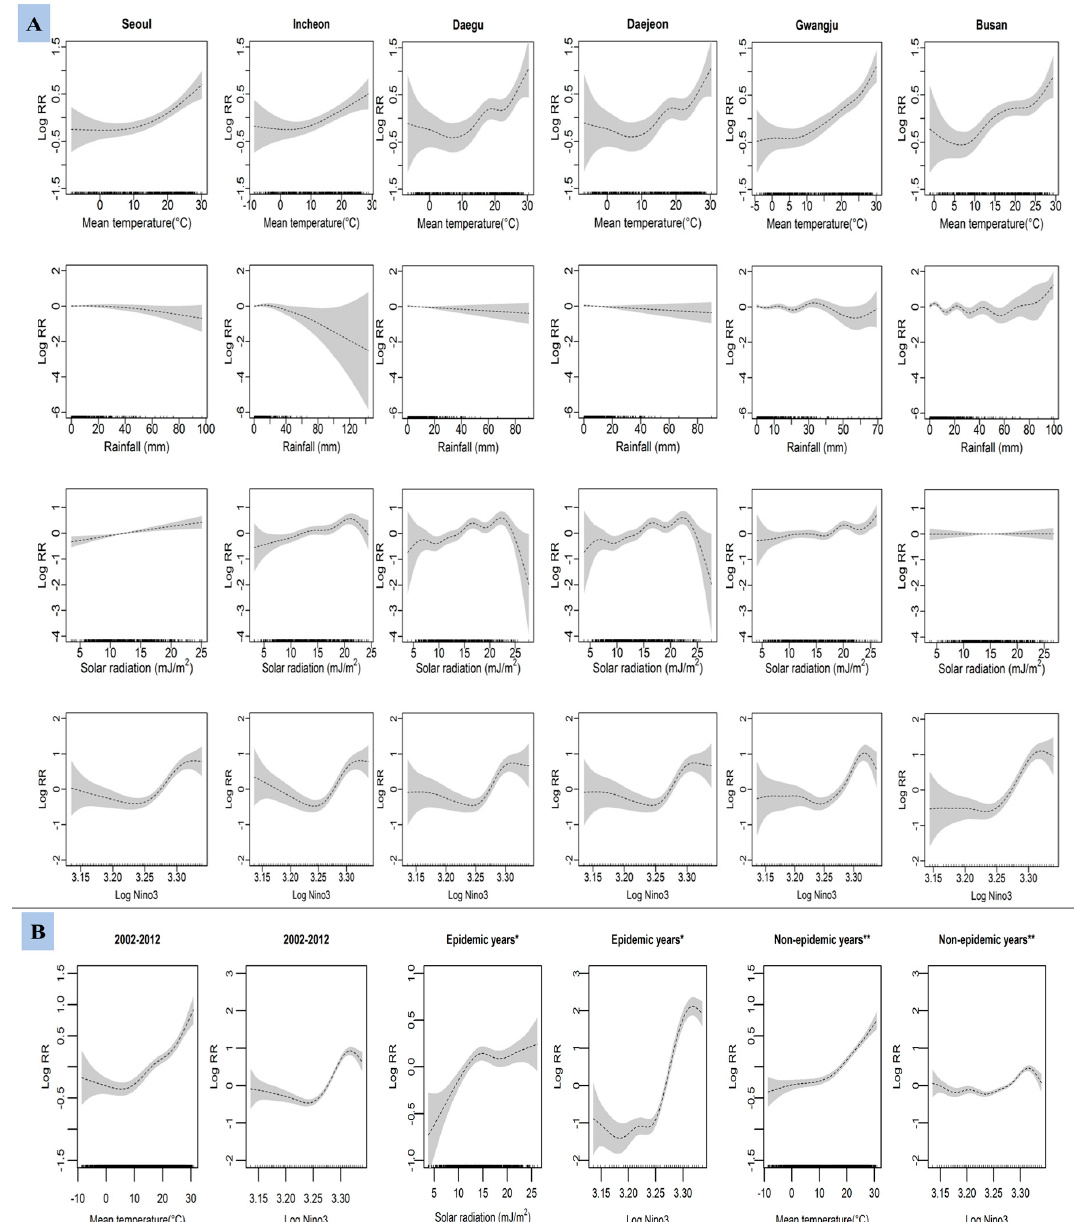
Figure 5. Generalized additive model for province-specific ( A ) and generalized additive mixed model for province-combined ( B ) associations in between the number of aseptic meningitis cases and weekly variations in climate factors in six metropolitan provinces of Korea from 2002 to 2012. * epidemic years (2002, 2005, and 2008); ** non-epidemic years (years excluding the outbreak years). Solids lines in each figure represents log relative risk (RR) at 95% confidence interval (shadows).